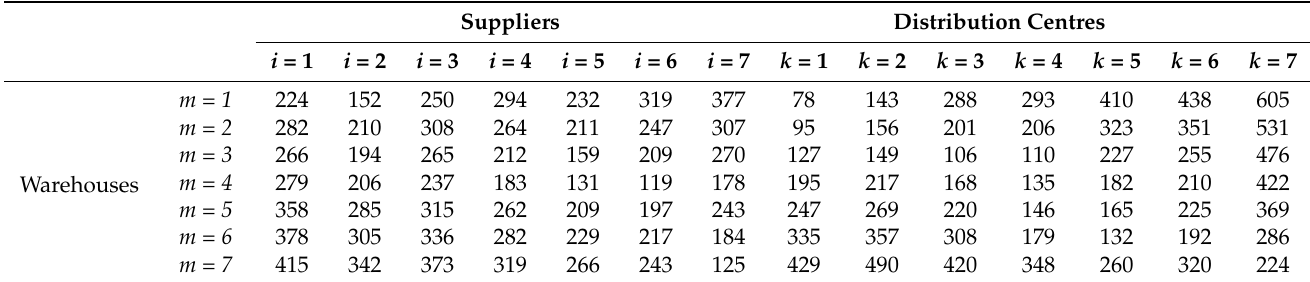
Table A1. Used distances between warehouses and both suppliers and distribution centres (km).